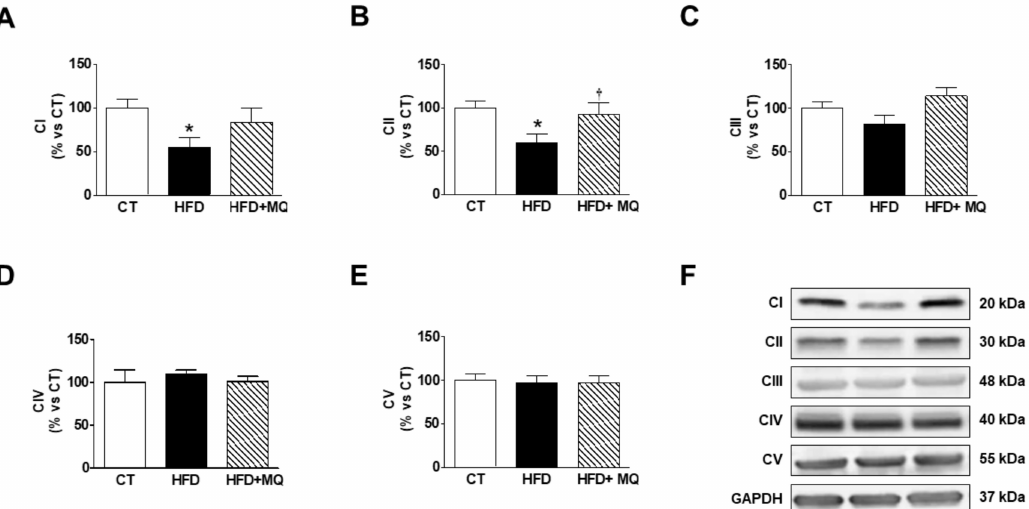
Figure 6. E ff ects of the mitochondrial antioxidant MitoQ (MQ) on mitochondrial complexes protein levels in the hearts of obese rats. Hearts from rats fed a standard diet (CT) or a high fat diet (HFD) treated with vehicle or with MQ (200 µ M) were analyzed. Protein expression of mitochondrial complexes ( A ) I (subunit NDUFB8), ( B ) II (SDHB subunit of complex II), ( C ) III (core protein 2 UQCRC2), ( D ) IV (MTCO1 subunit 1), and ( E ) V (alpha subunit) are presented. ( F ) Representative blots for mitochondrial complexes protein expressions. Bar graphs represent the mean ± SEM. of 6–8 animals normalized to glyceraldehyde-3-phosphate dehydrogenase (GAPDH). * p < 0.05 vs. control group. † p < 0.05 vs. HFD